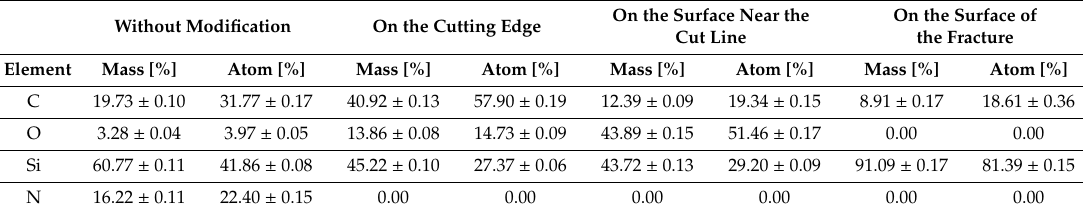
Table 3. Chemical composition of examined